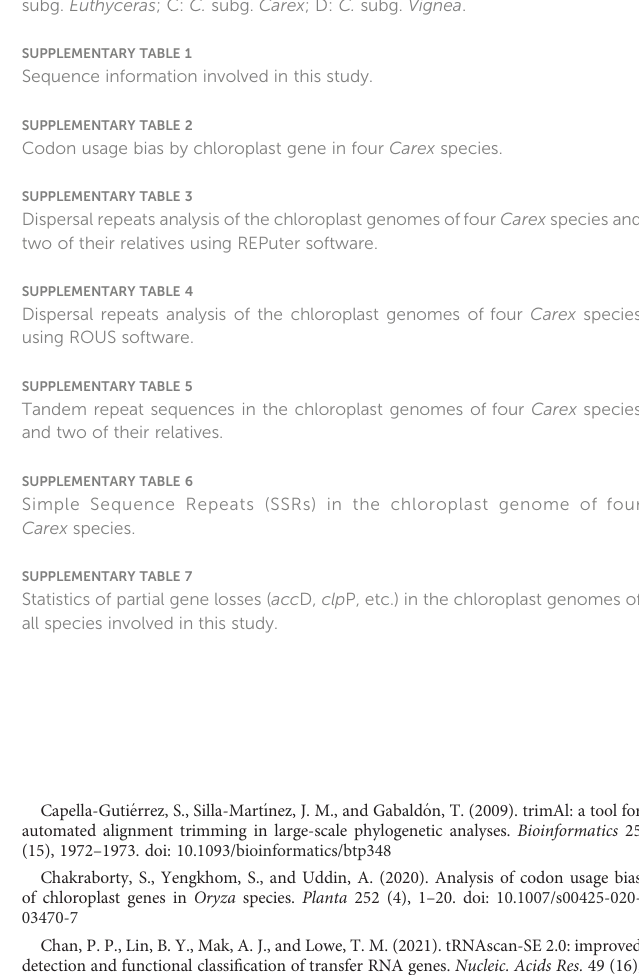
SUPPLEMENTARY FIGURE 1 Chloroplast genome maps of four Carex species assembled in this study. The thick lines on the outer circle indicate the inverted repeat regions (IRa and IRb). The innermost trace indicates GC content. Genes on the outside of the map are transcribed clockwise, and genes on the inside of the map are transcribed counterclockwise. SUPPLEMENTARY FIGURE 2 Mauve alignment of chloroplast genomes of 8 species in Cyperaceae and Oryza sativa (Poaceae). Complete chloroplast genome sequences were aligned in Geneious using the Mauve algorithm for linear comparison of rearrangements across the Cyperaceae. Locally collinear blocks (LCBs) are coloured to indicate syntenic regions. Histograms within each block represent the degree of sequence similarity. Inversions resulting in strand change are represented as offset LCBs (below). The small boxes below each chloroplast genome indicate genes; upper and lower boxes are transcribed counterclockwise and clockwise, respectively. Red boxes indicate ribosomal RNA genes. SUPPLEMENTARY FIGURE 3 Maximum likelihood (ML) tree of Carex species based on IGS sequence. Bootstrap values of ML are given at each branch. Chloroplast genomes assembled in this study are highlighted in red. A: C. subg. Siderosticta ; B: C. subg. Euthyceras ; C: C. subg. Carex ; D: C. subg. Vignea . SUPPLEMENTARY TABLE 1 Sequence information involved in this study. SUPPLEMENTARY TABLE 2 Codon usage bias by chloroplast gene in four Carex species. SUPPLEMENTARY TABLE 3 Dispersal repeats analysis of the chloroplast genomes offour Carex species and two of their relatives using REPuter software.